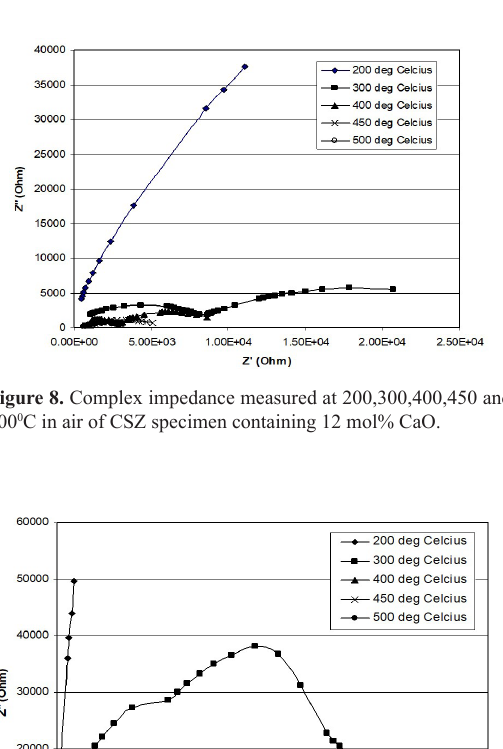
versus Z”, where Z’ and Z” are the complex impedance’s real and virtual components. The electrode effect, grain-boundary effect, and lattice effect, in that sequence, cause arcs 1, 2, and 3 with increased frequency 28 .